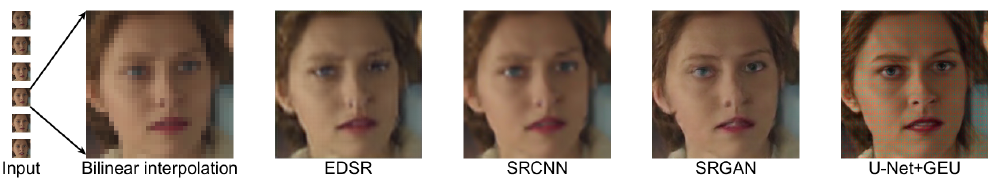
Figure 2. Different face super-resolution methods with scale factor 8. From the human perception point of view, it is better to have checkerboard artifacts (U-Net+GEU) instead of artifacts and deformations from other methods.